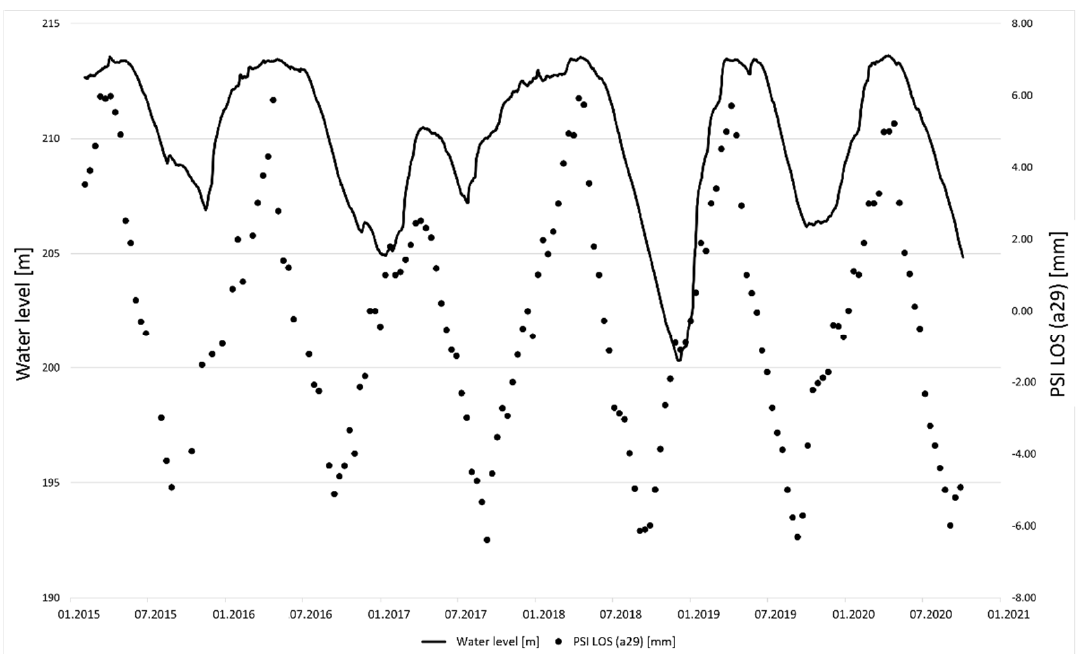
Figure 8. Comparison between PSI measurements and the water level of the Moehne lake. Seasonal patterns are similar to each other, and the connection between the two measurements is visible.